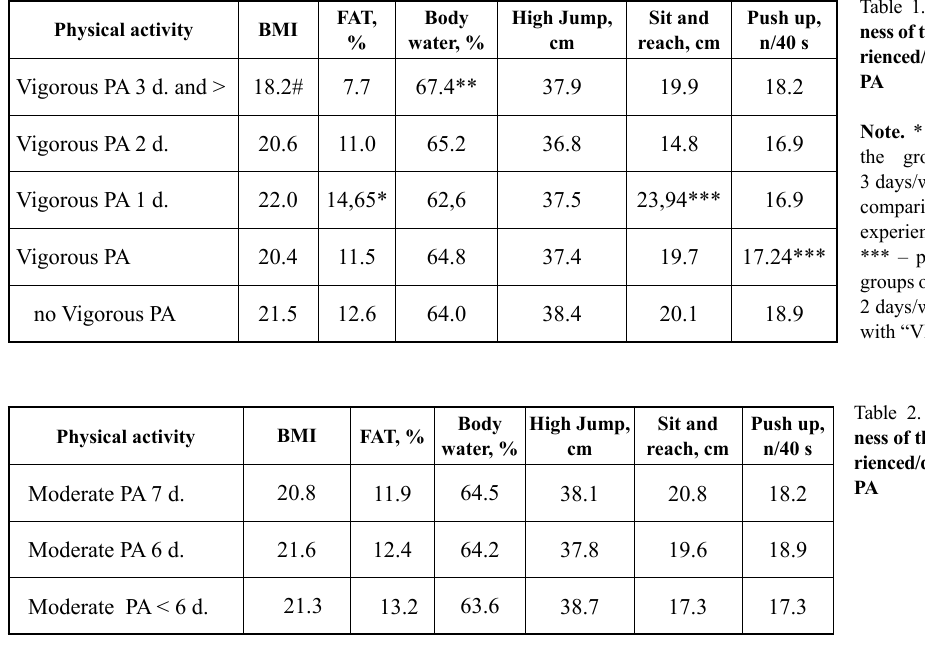
Table 1. Health-related physical fit- ness of the adolescent boys who expe-